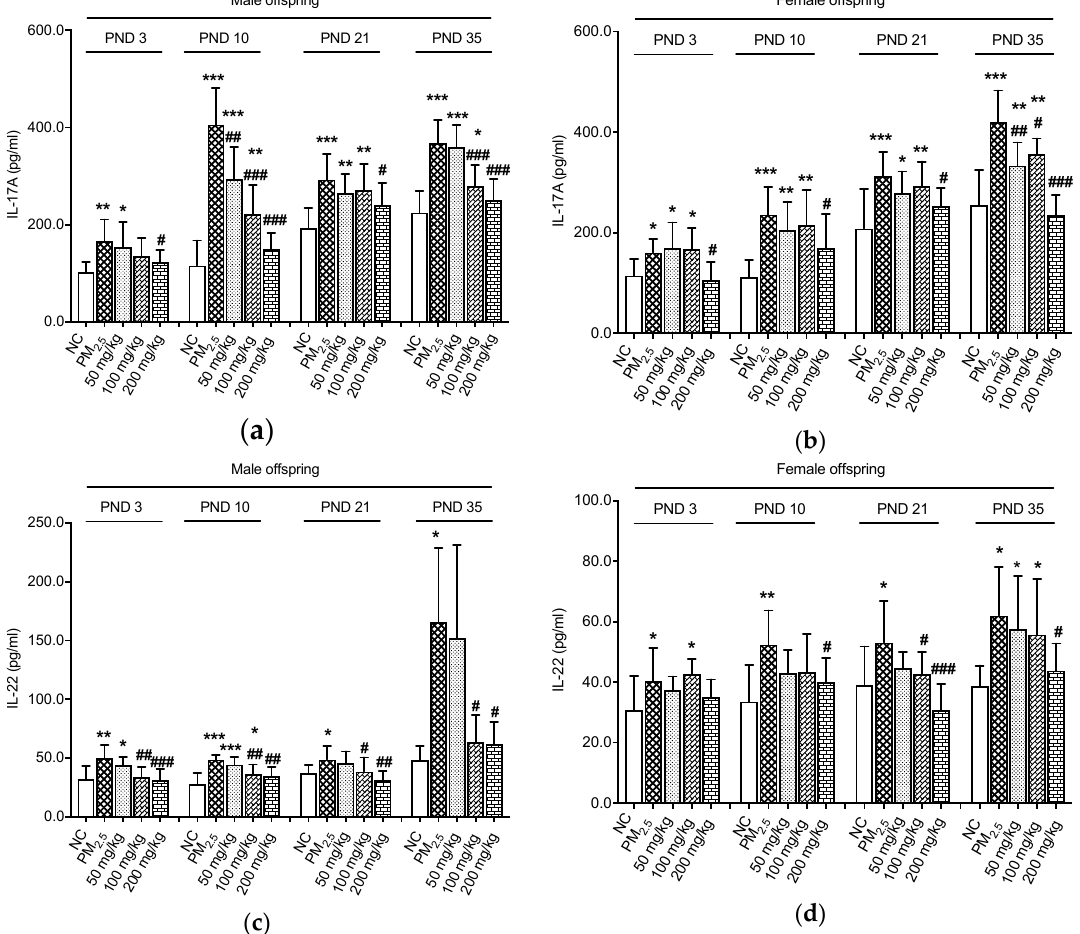
Figure 3. Effects on inflammation biomarkers of colon. ( a ) IL-17A levels of male offspring; ( b ) IL-17A levels of female offspring; ( c ) IL-22 levels of male offspring; ( d ) IL-22 levels of female offspring. Compared with the NC group, * indicates p < 0.05, ** indicates p < 0.01, *** indicates p < 0.001. Compared with the PM 2.5 group, # indicates p < 0.05, ## indicates p < 0.01, ### indicates p < 0.001.